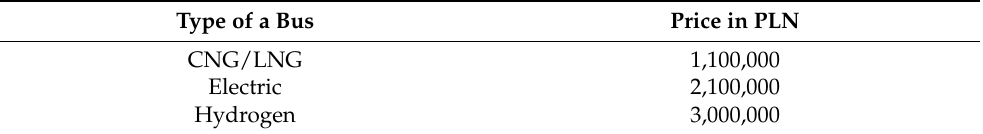
Table 4. Cost of buying a bus